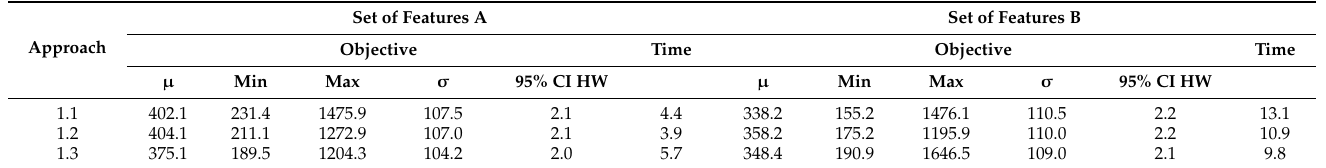
Table 7. Objective function values and run times (in hours) of the clustering approaches 1.1–1.3 using two different sets of features and the same stop criteria for the SDSMO model.